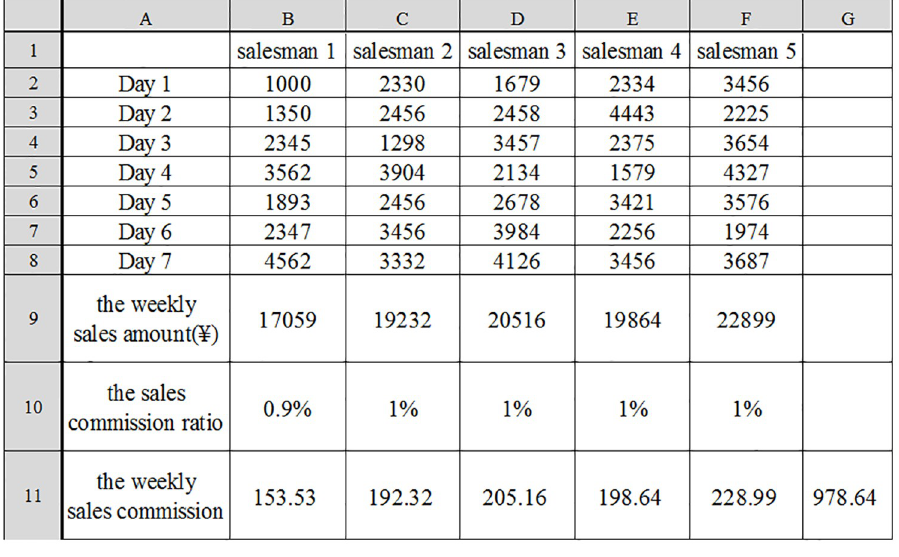
Fig 4. A spreadsheet in example